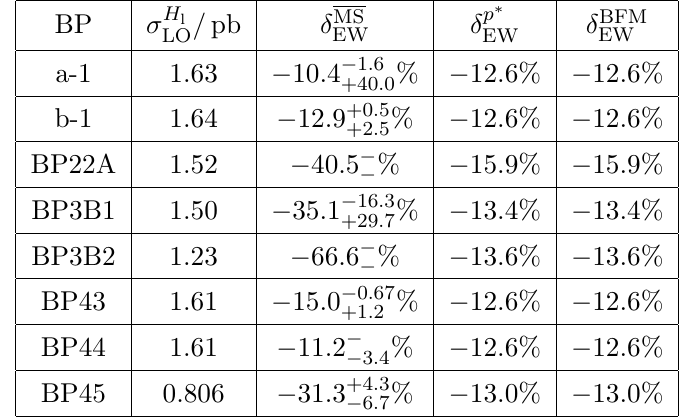
Table 8. Relative NLO corrections (cid:14) EW to SM-like Higgs-boson production in Higgs strahlung pp H l (cid:22) (cid:0) (cid:22) + in alignment scenarios in the 2HDM. The results in the MS scheme are given at the ! central scale (cid:22) 0 = 2 M h = 250 : 18 GeV with scale uncertainties estimated including the RG running of parameters as given by (6.7). Both on-shell schemes agree within the integration error, and only results in the p (cid:3) scheme are given. The SM EW correction is (cid:14) EW = 12 : 4%. (cid:0)